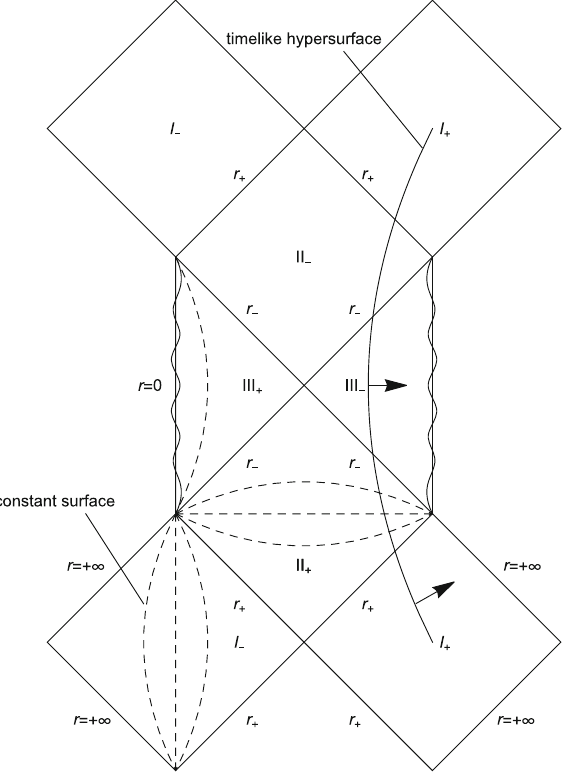
Fig. 5 The Penrose diagram of a four-dimensional EGB vacuum solu- tion with M > α is